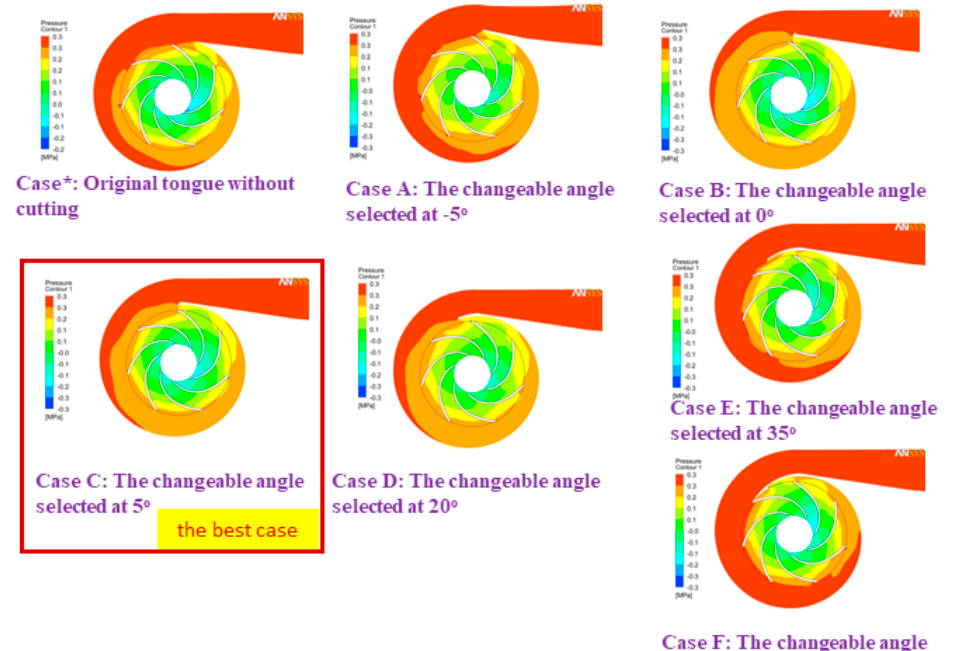
Figure 13. A comparison of the pressure spectrum of different angles.